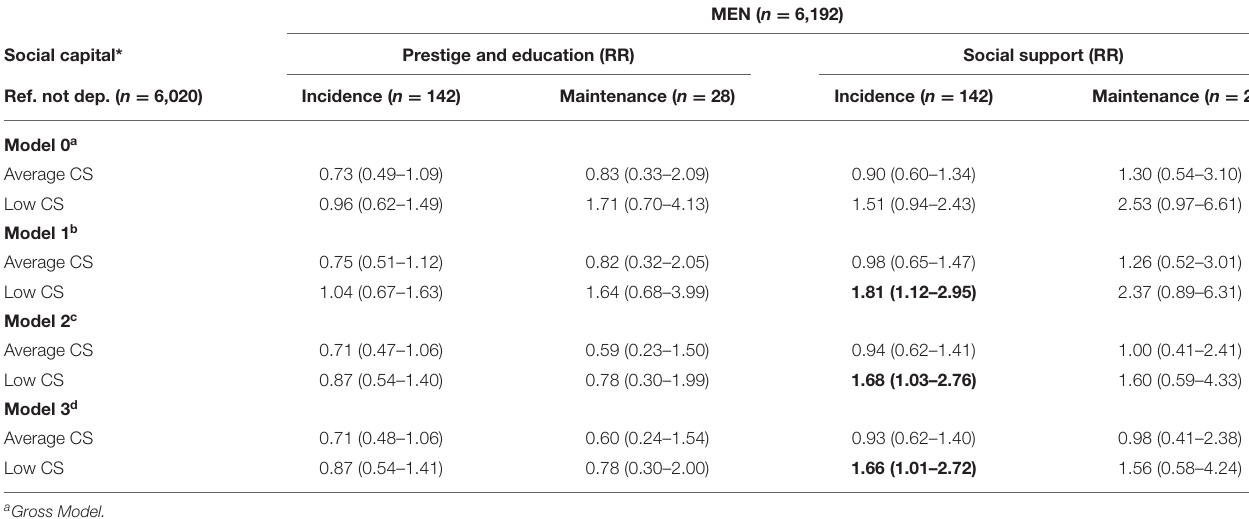
TABLE 2 | Association between social capital, incidence and maintenance of depression among men from ELSA-Brasil.